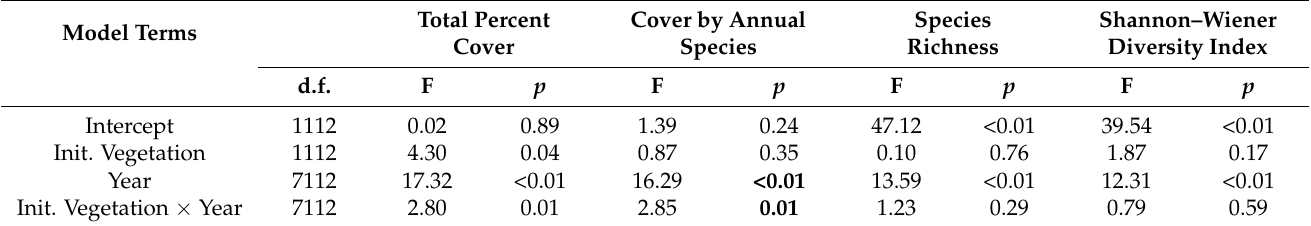
Table 1. Repeated Measures ANOVA Results of the Effects of Initial Vegetation State and Year on the Difference in Total Percent Cover, Cover by Annual Species, Species Richness, and Shannon–Wiener Diversity Index between Fenced and Unfenced